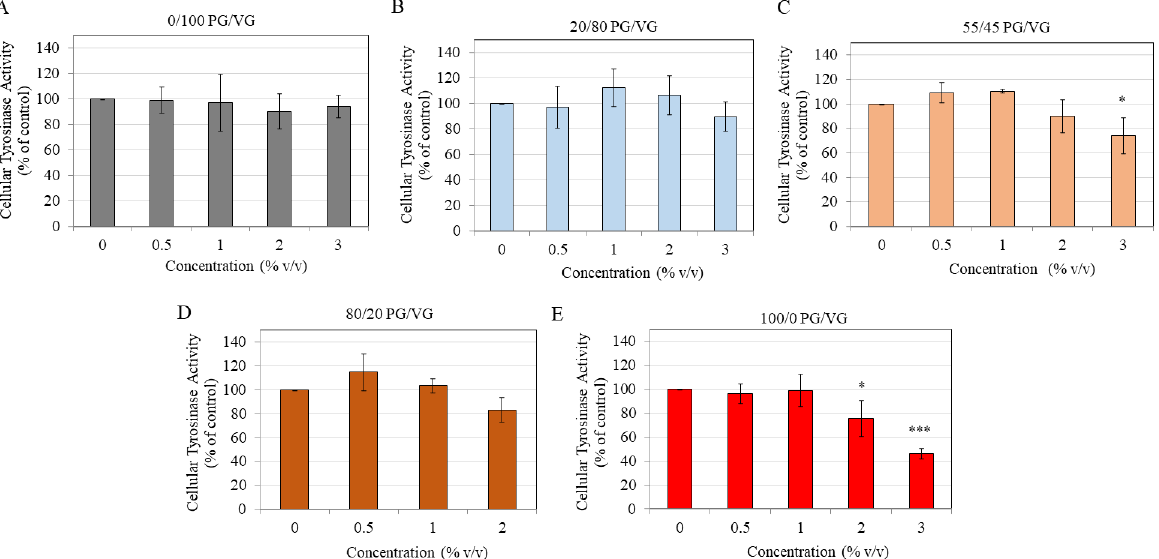
Figure 5. Tyrosinase activity in lysates of human melanocytes after 48 h exposure to e-liquids containing PG/VG at a ratio of ( A ) 0/100; ( B ) 20/80; ( C ) 55/45; ( D ) 80/20 and; ( E ) 100/0; (One-way ANOVA with Dunnett’s post hoc test; * p < 0.05 and *** p < 0.001 vs. untreated control). All data is mean ± SD of at least three independent experiments.